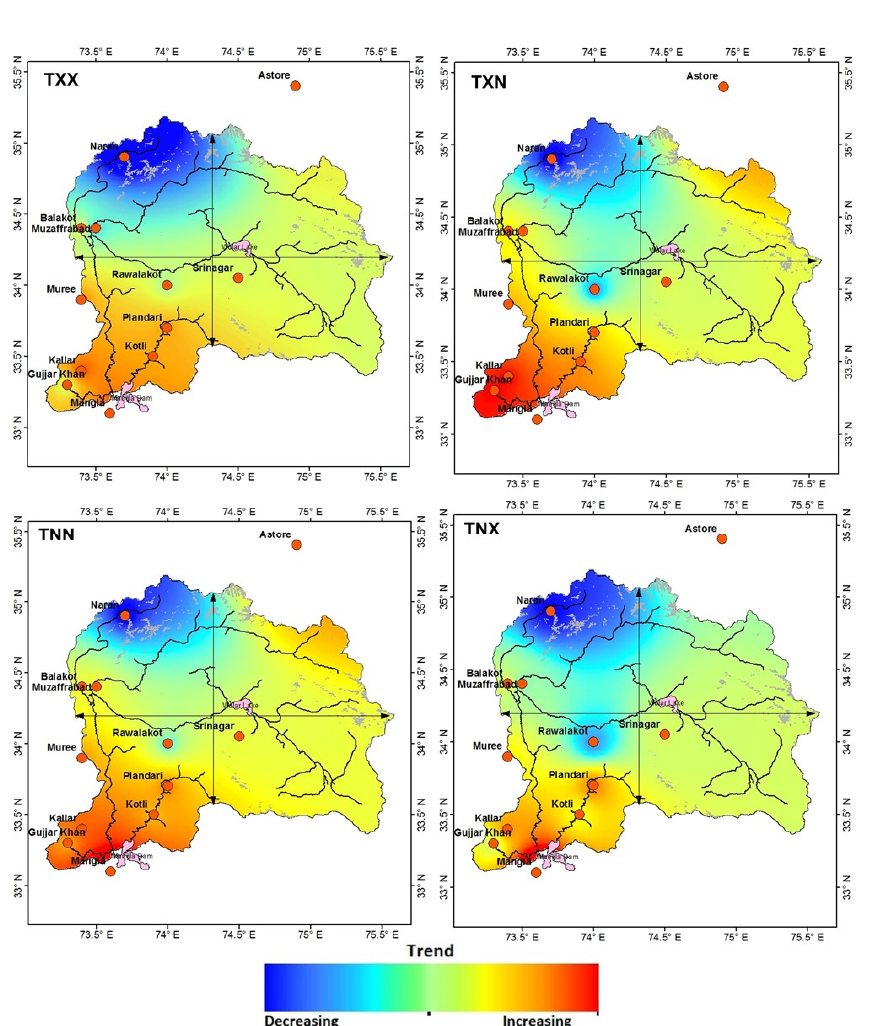
Figure 4. Spatial Trends of monthly maximum value of maximum temperature(TNX), monthly minimum value of maximum temperature(TXN), monthly maximum value of minimum tempera- ture(TXX), monthly maximum value of minimum temperature(TNN).